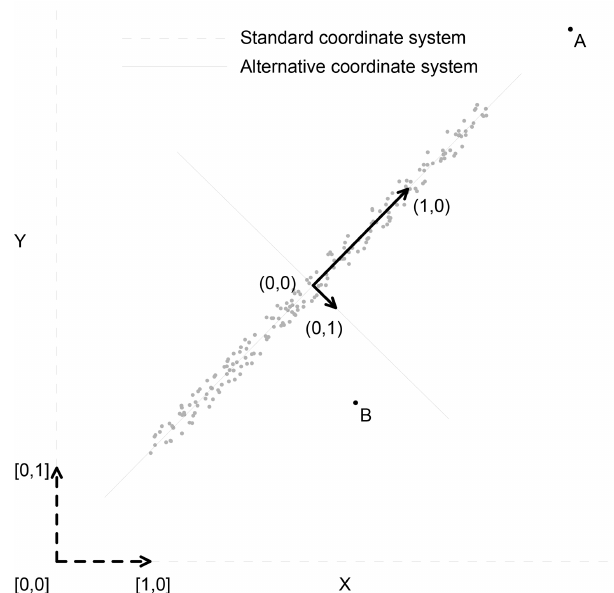
Figure 7. The difference between the ordinary and dependence out- liers. The dashed lines define the standard coordinate system; the solid lines define an alternative coordinate system. The outlying points in the standard coordinate system are ordinary outliers (point A); the outlying points in the alternative coordinate system are de- noted as dependence outliers (point deviating from the dependence structure, point B). The construction of alternative coordinates is explained in the text.